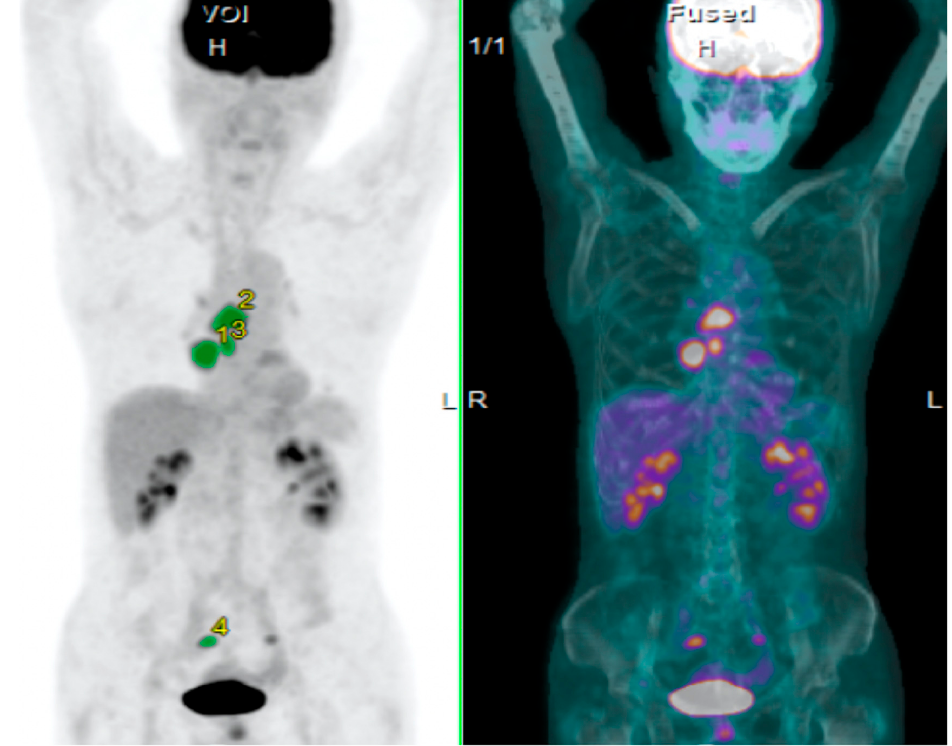
Figure 1. Imaging from a positron emission tomography (PET) scan of non-small cell lung cancer (NSCLC), indicating the measurement of SUVmax, metabolic tumor volume (MTV) and total lesion glycolysis (TLG) on 2-deoxy-2-[ 18 F]fluoro- D -glucose ( 18 F-FDG).